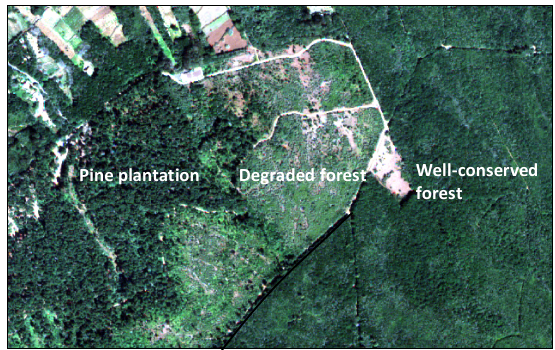
Figure 1. True color combination of WV2 image for the study area, and description of the three main vegetation covers present.